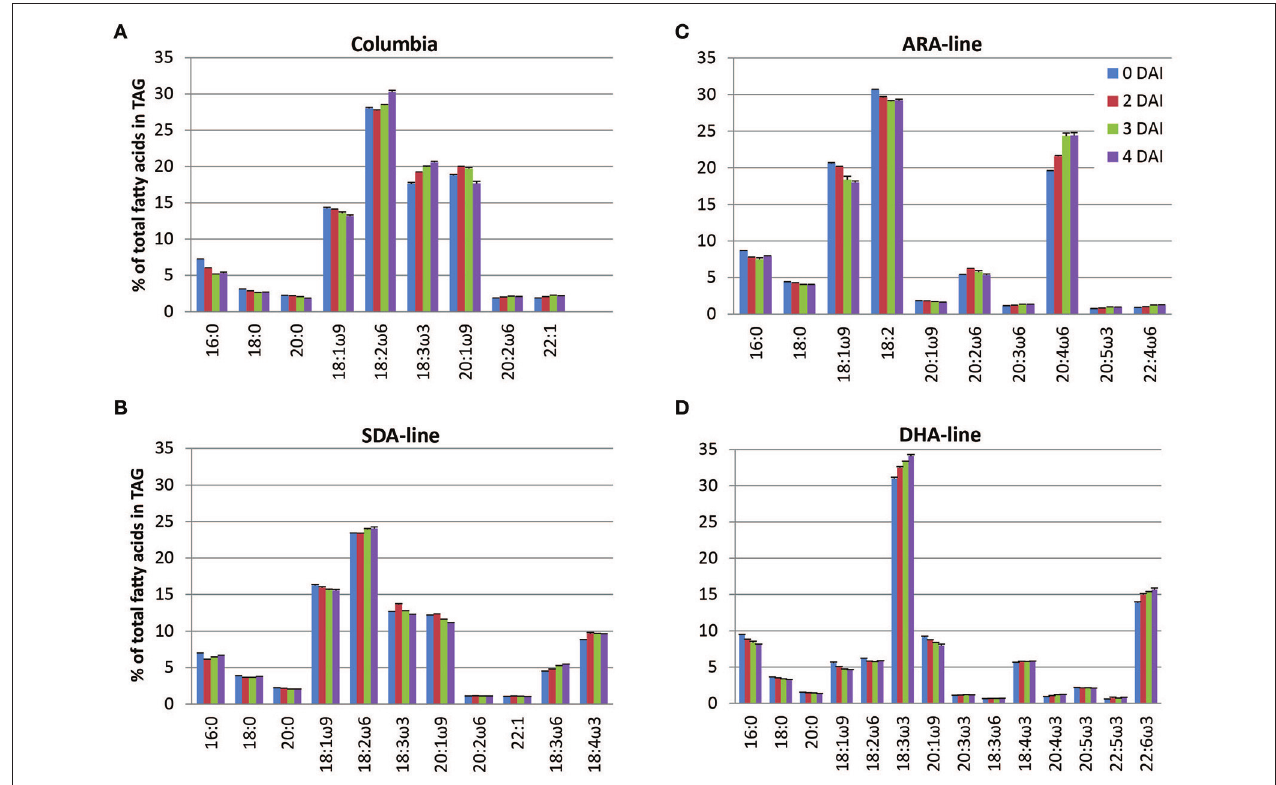
FIGURE 1 | Profiles of major and engineered fatty acids of triacylglycerols in seedlings of Arabidopsis lines. Panels (A–D) are for Columbia, SDA-, ARA-, and DHA-lines, respectively. The error bars denote standard deviation from triplicates. ALA in the ARA-line was minor component, and not included here.